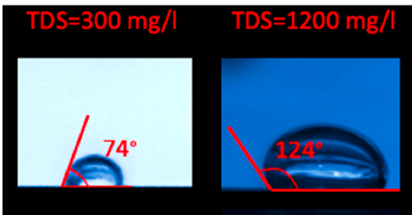
Figure 7. Contact angle measurements for water at TDS values of ( left ) 300 mg/L and ( right ) 1200 mg/L at heat flux of 50 kW/m 2 .